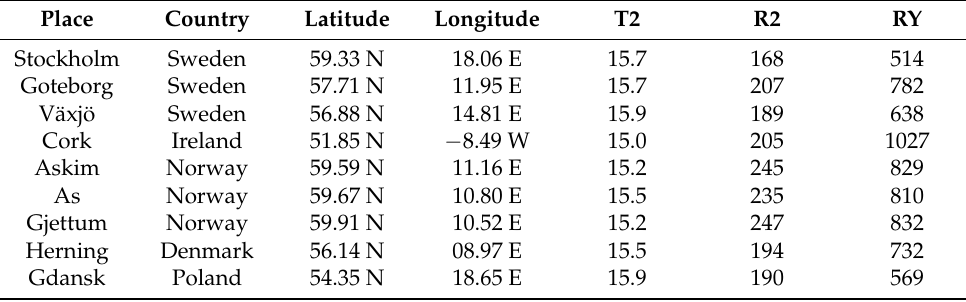
Table 5. Locations of rainfall data for the PMP study illustrated in Figure